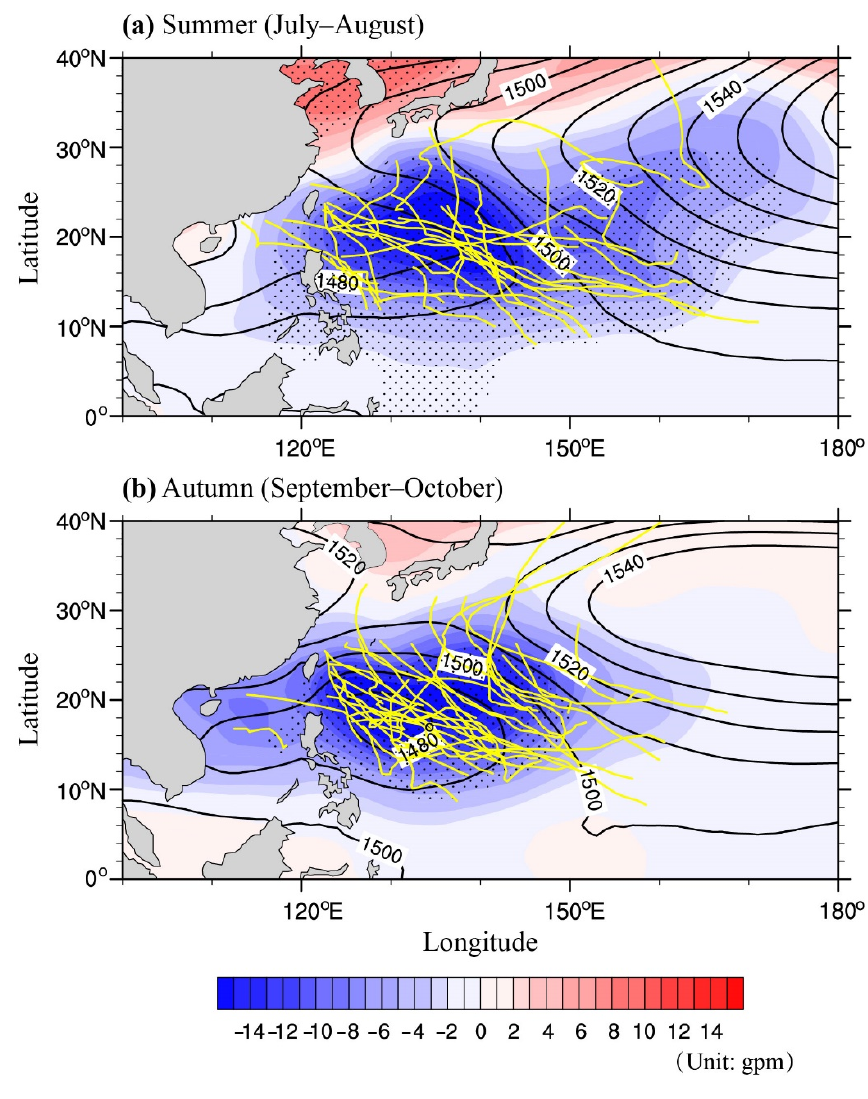
Figure 6. Composite geopotential height of Environmental TCs (contours; unit: gpm) and its difference between VOR TCs and Environmental TCs (shading; unit: gpm) at 850 hPa. Dots indicate areas of >90% confidence level according to the Student’s t -test for the difference between VOR TCs and Environmental TCs. The yellow lines indicate the tracks of VOR TCs during their intensification period: ( a ) TCs in summer (July–August) and ( b ) TCs in autumn (September–October).